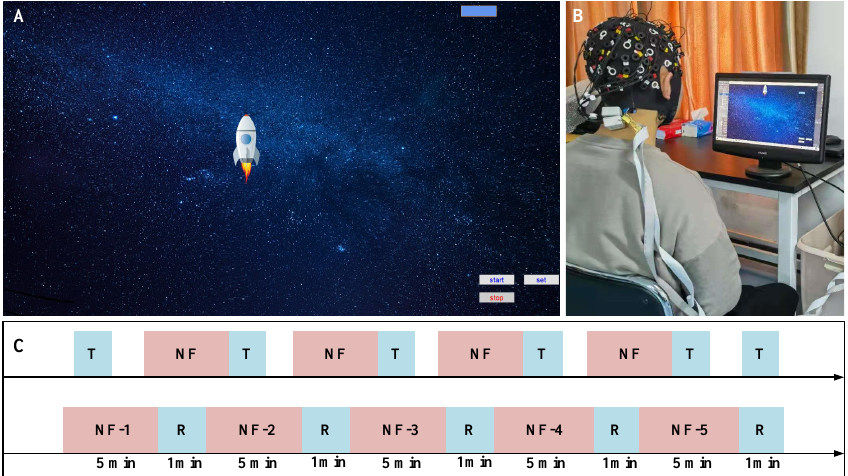
Figure 2. ( A ) neurofeedback system interface, ( B ) participant neurofeedback training scene, ( C ) train- ing paradigm design; NF = Neurofeedback, T = Test, and R = Rest.